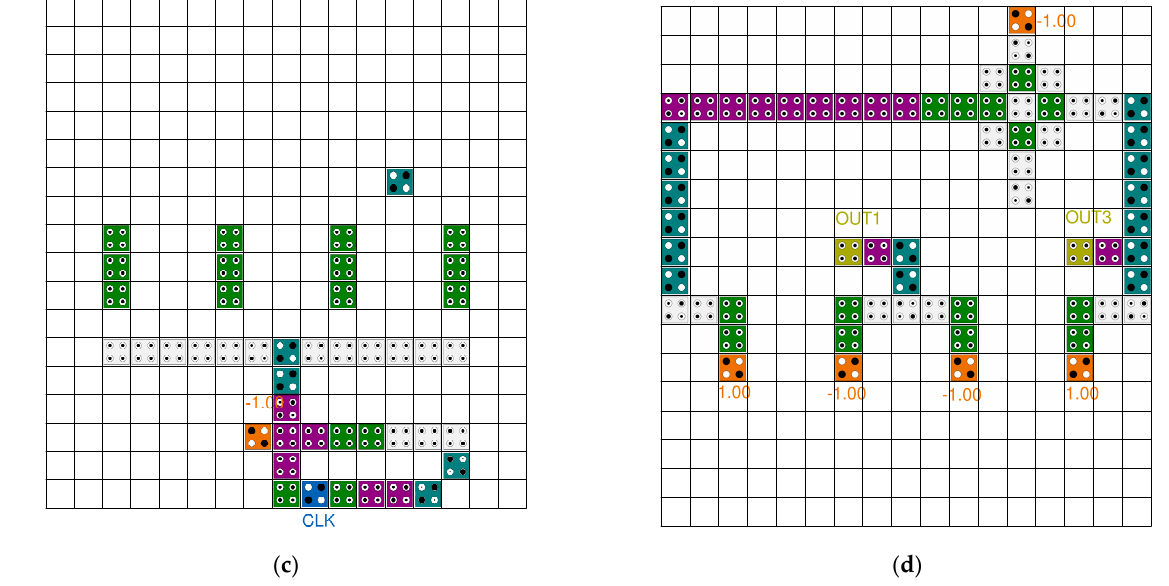
Figure 14. Proposed 4-bit level triggered LFSR structure: ( a ) Top view; ( b ) layer 1; ( c ) layer 2; and ( d ) layer 3.